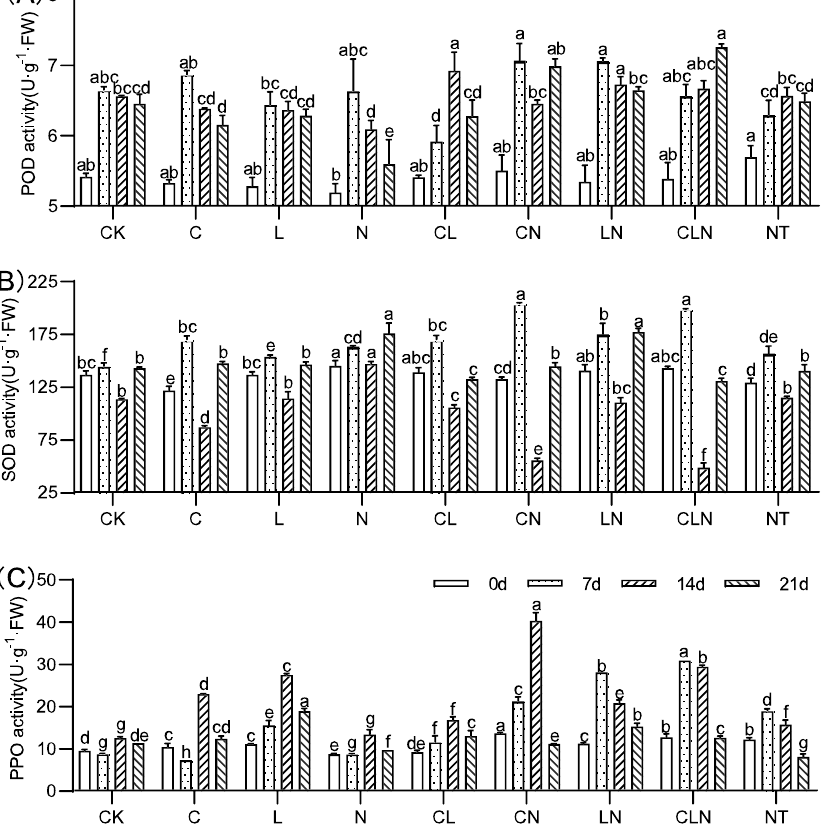
Figure 6. POD ( A ), SOD ( B ) and PPO ( C ) activity under treatments at the fruiting period in papaya. Whereas CK—control without the use of bio-pesticides, C—use of 0.50 g L − 1 Chitosan, L—use of 10.00 g L − 1 Lentinan, N—use of 0.05 g L − 1 Ningnanmycin, CL—Chitosan plus Lentinan, CN—Chitosan plus Ningnanmycin, LN—Lentinan plus Ningnanmycin, CLN—Chitosan plus